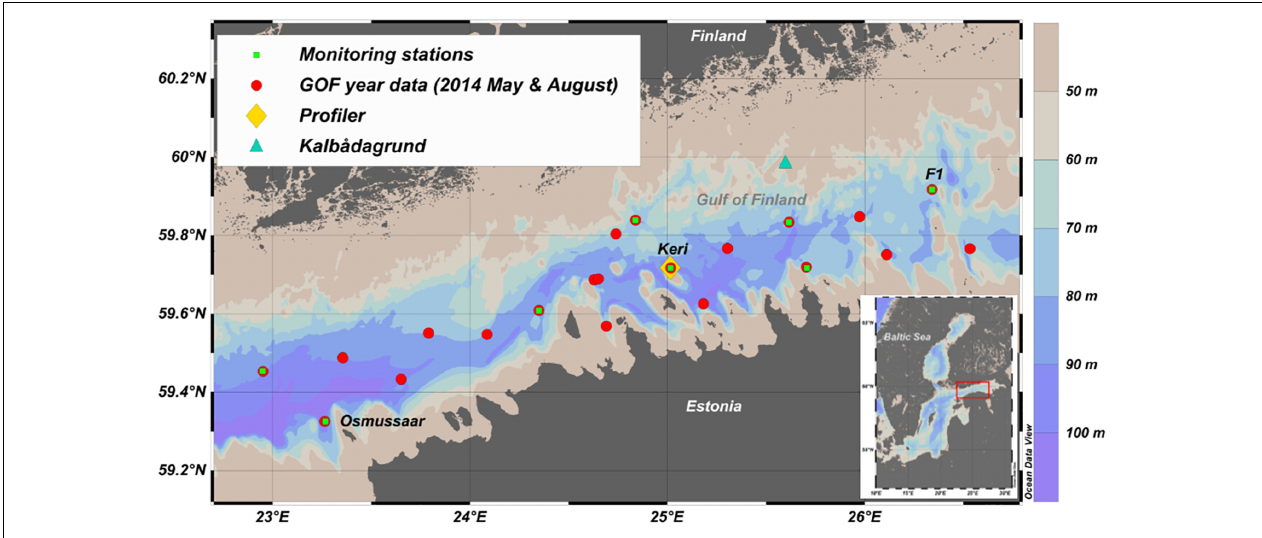
FIGURE 1 | The location of the autonomous bottom-mounted profiler (yellow diamond) in the Gulf of Finland (GoF). National open sea monitoring stations are marked with green squares and CTD-stations from the GoF Year 2014 surveys, used to determine the inclination of the hypoxic layer in the gulf, are marked with red circles. Kalbådagrund wind station is marked with a blue triangle. This map was generated using Ocean Data View 4.7.10 software (Schlitzer, 2018).